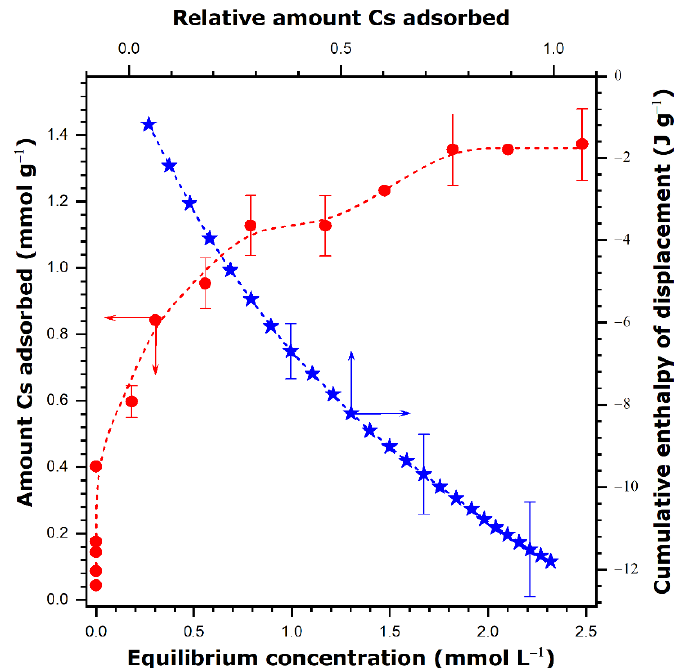
Figure 8. Sorption isotherm ( red circles ) for cesium cations onto VO x -E1 sample from single-component solutions in ultrapure water at 298 K and the corresponding cumulative enthalpy of displacement curve ( blue stars ). The error bars represent, for selected points, the maximum percentage error in the sorption experiments and the repeatability of the enthalpy measurements. The dashed lines are drawn to guide the eye.